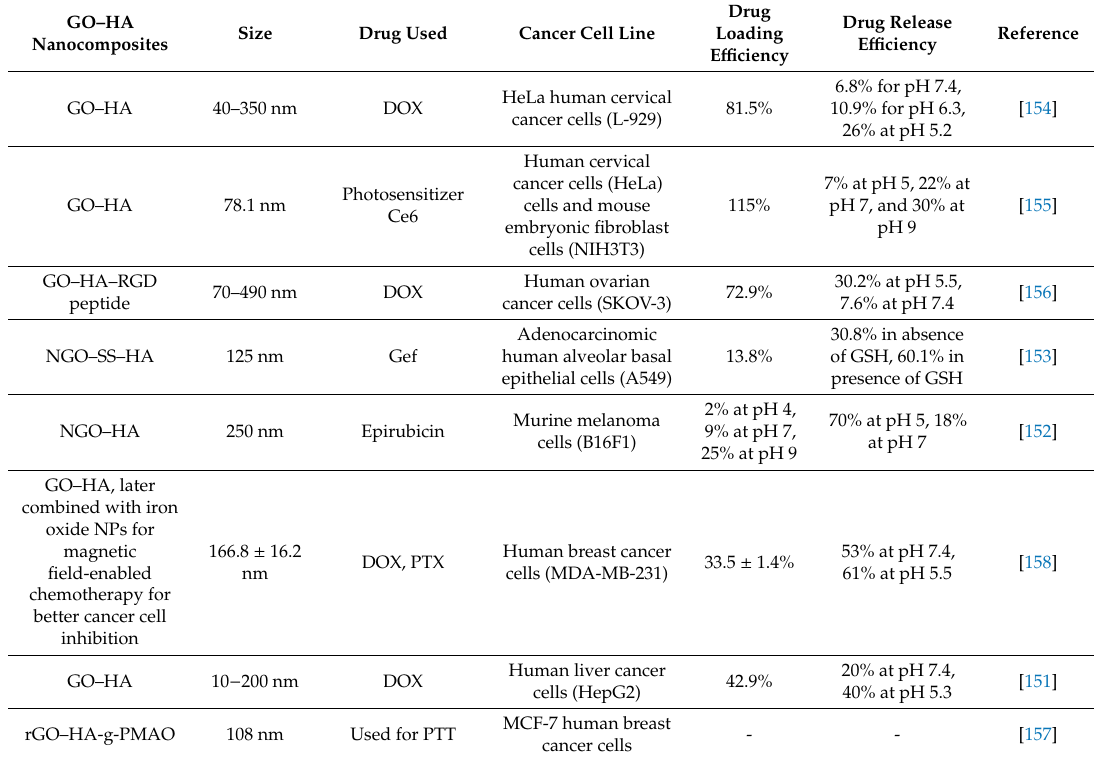
Table 3. Graphene oxide (GO)– hyaluronic acid (HA) composites, their size, the drug used, type of cancer cell treated, drug loading, and release e ffi